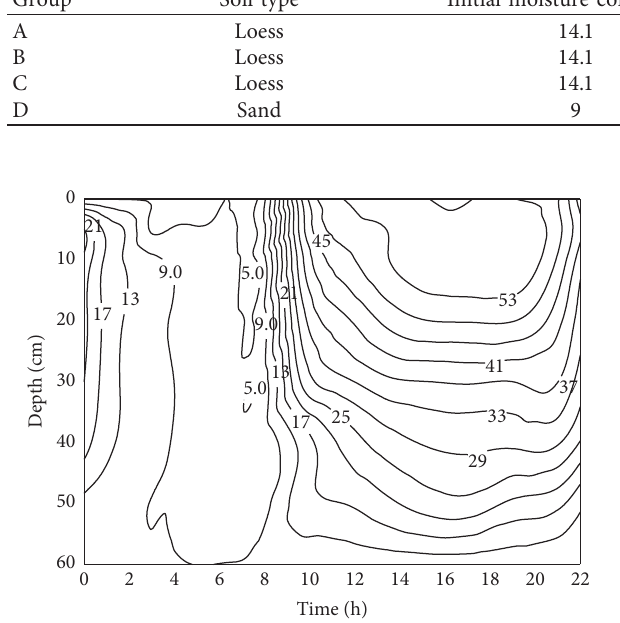
Figure 8: Temperature distribution along the depth of the soil